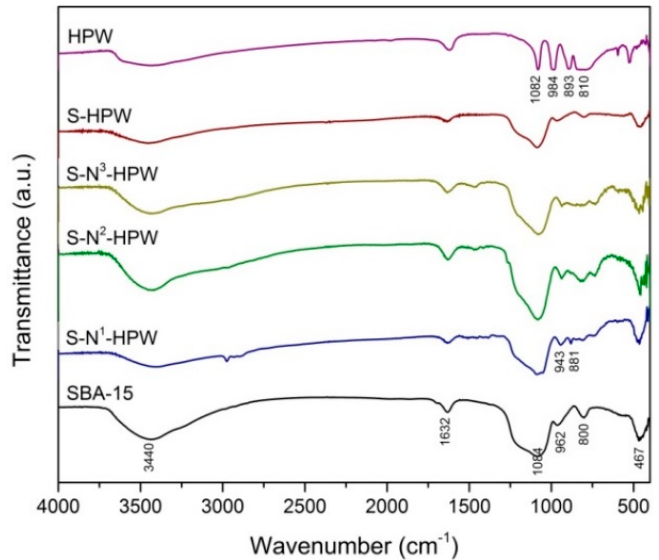
Figure 3. Fourier transform infrared spectroscopy (FT-IR) spectra of SBA-15, HPW, S-N x -HPW, and S-HPW materials.